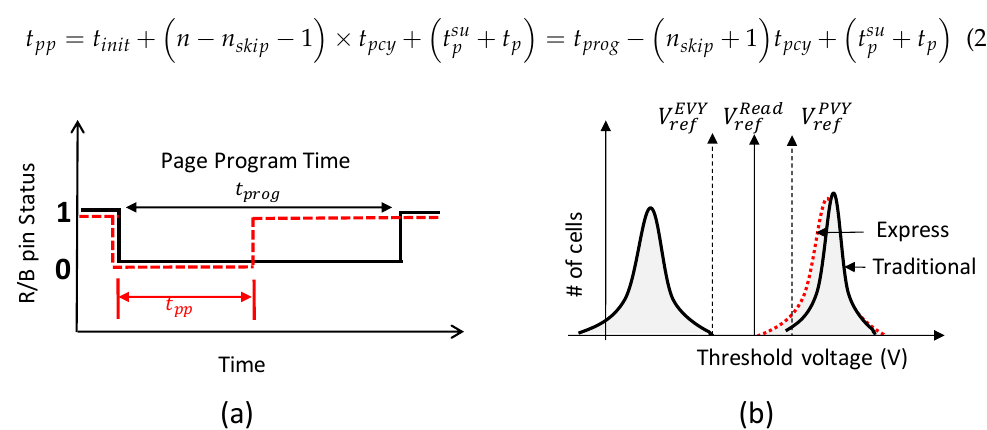
Figure 4. Nominal (solid black line) and partial-page program (dashed red line) operations: ( a ) timing diagrams; ( b ) the threshold voltage distributions for the erased and programmed states, and the corresponding reference